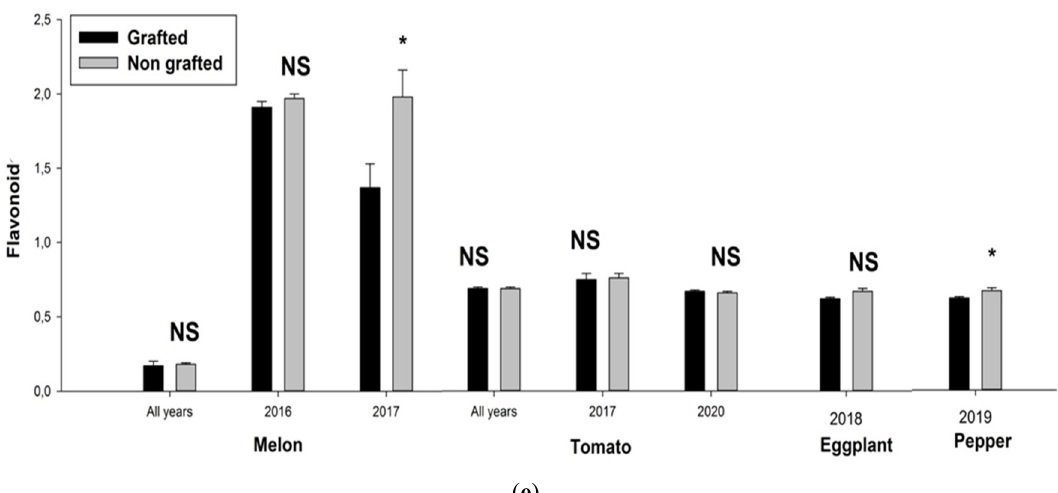
Figure 3. Variation of ( a ) Greenseeker (NDVI), ( b ) RGB-based Triangular Greenness Index (TGI), ( c ) RGB-based Crop Senescence Index (CSI), ( d ) Nitrogen Balance Index (NBI), and ( e ) Flavonoid (Flav) values between two treatments (grafted, non-grafted) for four crops (melon, tomato, eggplant, pepper) during five years of experience (2016–2020). For melon, we present both the combined and separate analyses for 2016 and 2017. Concerning the tomato crop combined years and 2017 and 2020 are shown. The eggplant crop was studied for just one year (2018) as well as pepper (2019). NS: non- significant ( p >0.05), *: weakly significant ( p <0.05), **: significant ( p <0.01), ***: highly significant ( p <0.001).